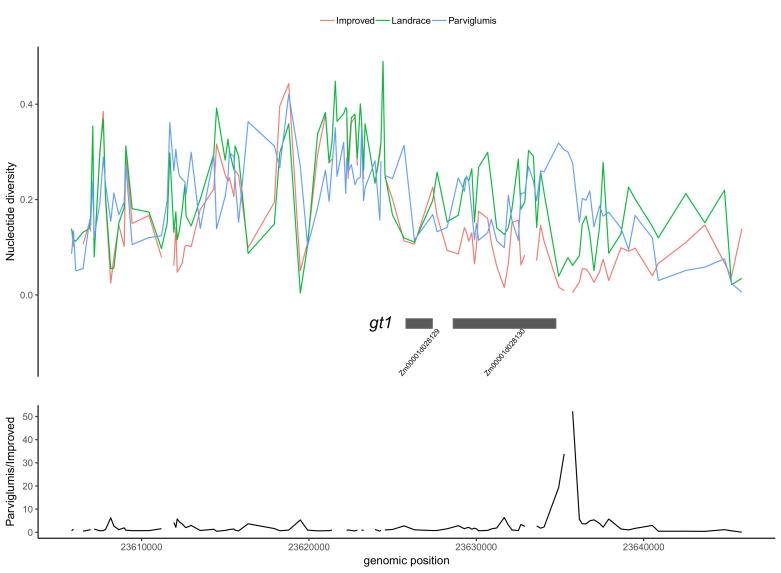
Nucleotide diversity analysis in the genomic region of gt1. The top panel shows the nucleotide diversity of different groups of maize lines. The bottom panel shows the division of nucleotide diversity of teosinte lines by that of the improved maize lines. Improved, improved maize lines. Landrace, maize landrace. Parviglumis, Z. mays ssp. parviglumis (teosinte lines).